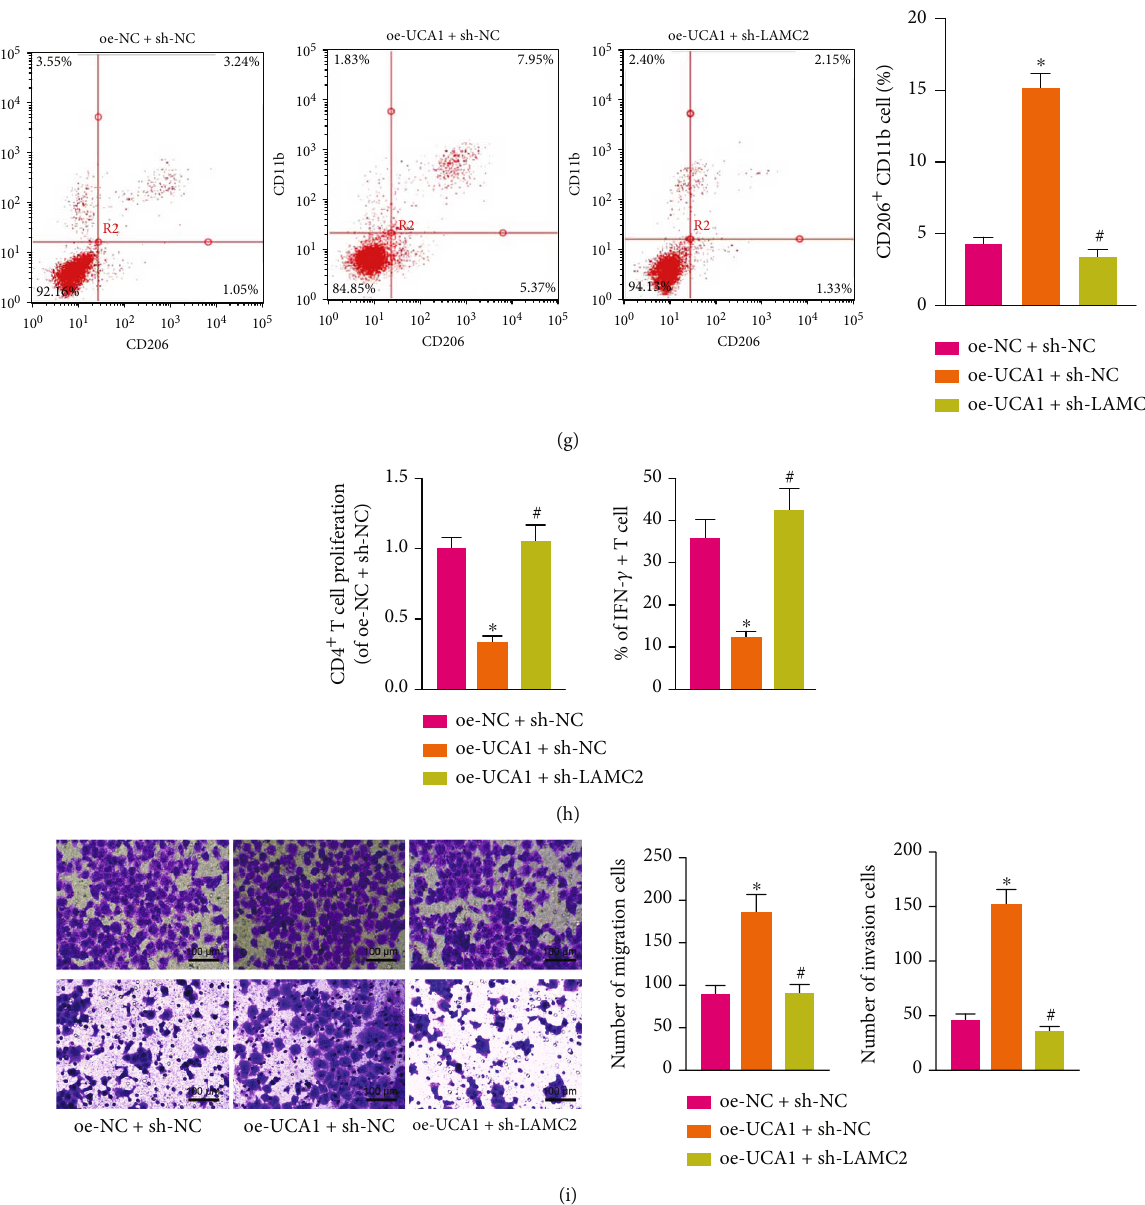
Figure 4: OSCC-CSC-derived sEVs (OSCC-CSC-sEVs) promote M2 polarization of macrophages by transferring UCA1 and targeting LAMC2. (a) UCA1 expression in Cal27-sEVs and Cal27-CSC-sEVs, measured by RT-qPCR. (b) Detection of UCA1 silencing e ffi ciency, determined by RT-qPCR. (c) UCA1 expression in sEVs from Cal27-CSCs treated with sh-UCA1, detected by RT-qPCR. (d) RT-qPCR determination of the expression of the UCA1 and M2 macrophage markers CD163, IL-10, and Arg-1 in macrophages cocultured with sEVs from Cal27-CSCs treated with sh-UCA1. (e) Detection of M2 macrophages after macrophage coculture with sEVs from Cal27- CSCs treated with sh-UCA1, determined by fl ow cytometry. (f) The expression of M2 macrophage markers (CD163, IL-10, and Arg-1) in macrophages after oe-UCA1 and sh-LAMC2 treatment, determined by RT-qPCR. (g) Detection of CD206 + CD11b + M2 macrophages after oe-UCA1 and sh-LAMC2 treatment, determined by fl ow cytometry. (h) The proliferation number of CD4 + T cells and the proportion of IFN- γ + T cells after coculture with macrophages treated with oe-UCA1 and sh-LAMC2, detected by fl ow cytometry. (i) Transwell assay detection of the migration and invasion ability of Cal27 cells cocultured with macrophages treated with oe-UCA1 and sh-LAMC2 (100 × ). ∗ p < 0 : 05 , # p > 0 : 05 . All cell experiments were repeated three